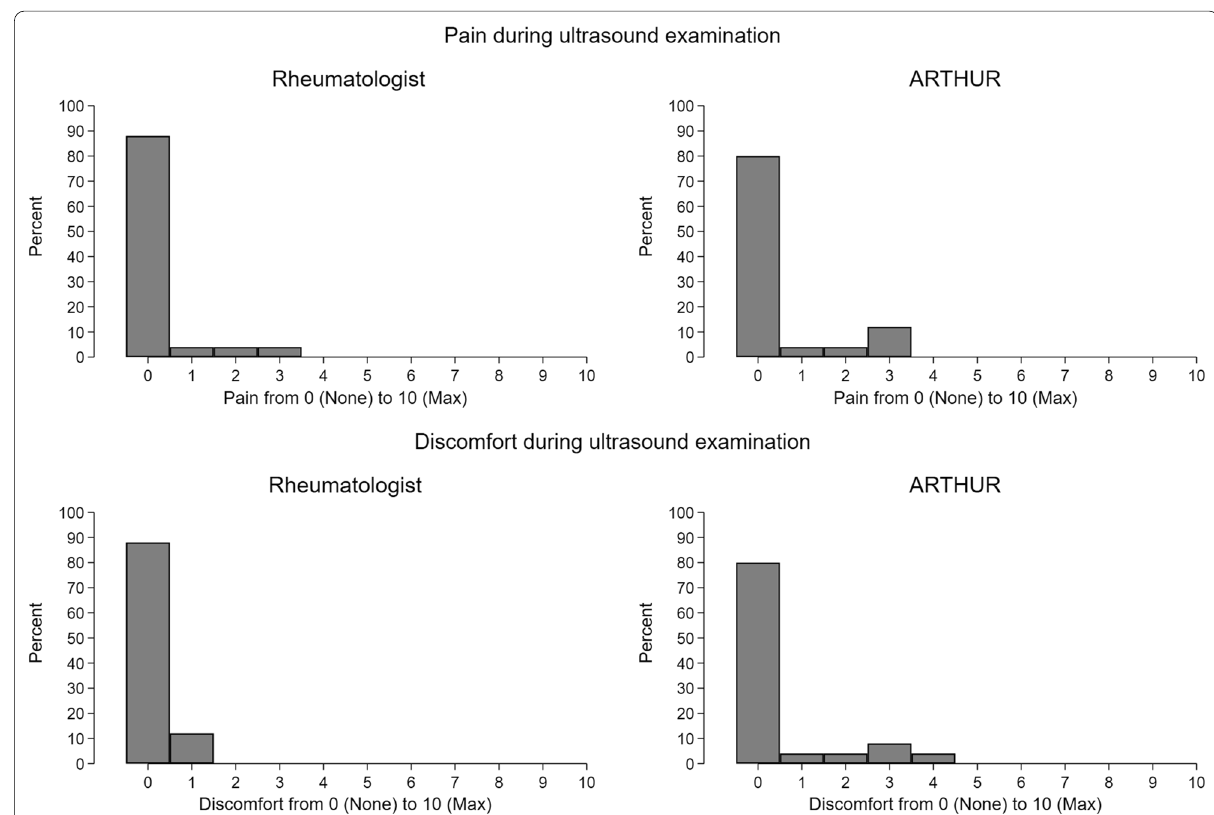
Fig. 4 Comparing pain and discomfort by examination by respectively rheumatologist and ARTHUR. There was no difference in pain or discomfort between examination by a rheumatologist and by ARTHUR ( p